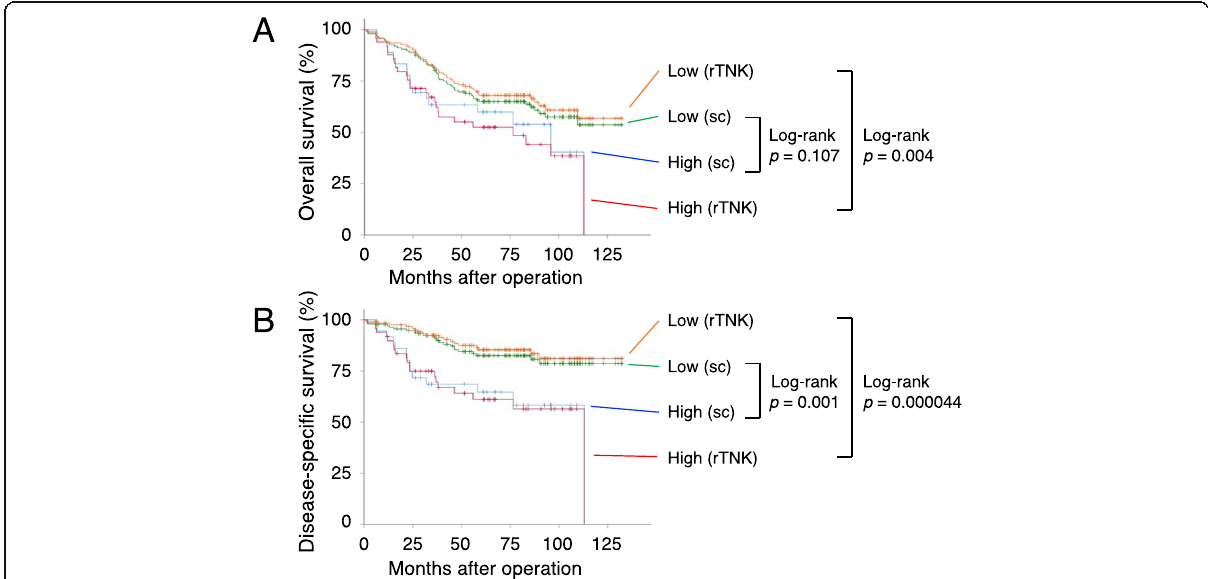
Fig. 5 Comparison of two AMIGO2 antibodies in AMIGO2 expression and survival in CRC patients. Cumulative survival rates were assessed using the Kaplan-Meier plot method. Differences were analyzed using the log-rank test. Overall survival ( A ) and disease-specific survival ( B ) are